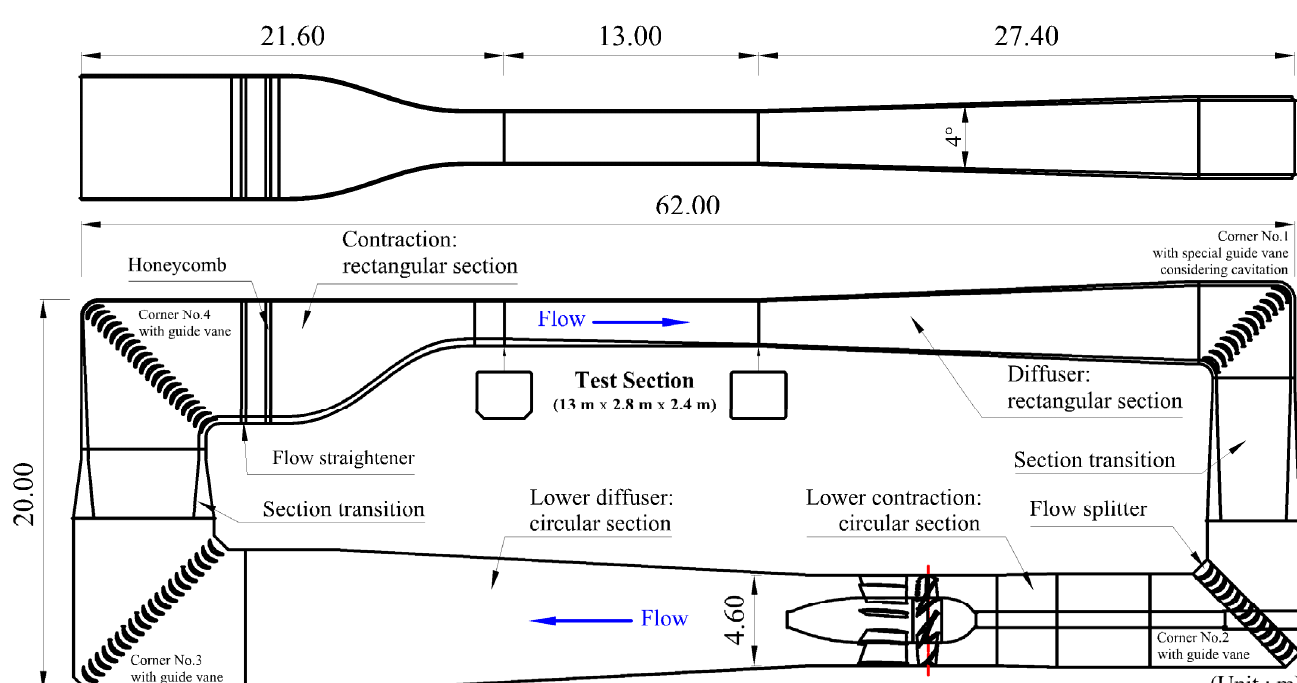
Figure 1. Geometry of DSME Large Cavitation Tunnel.